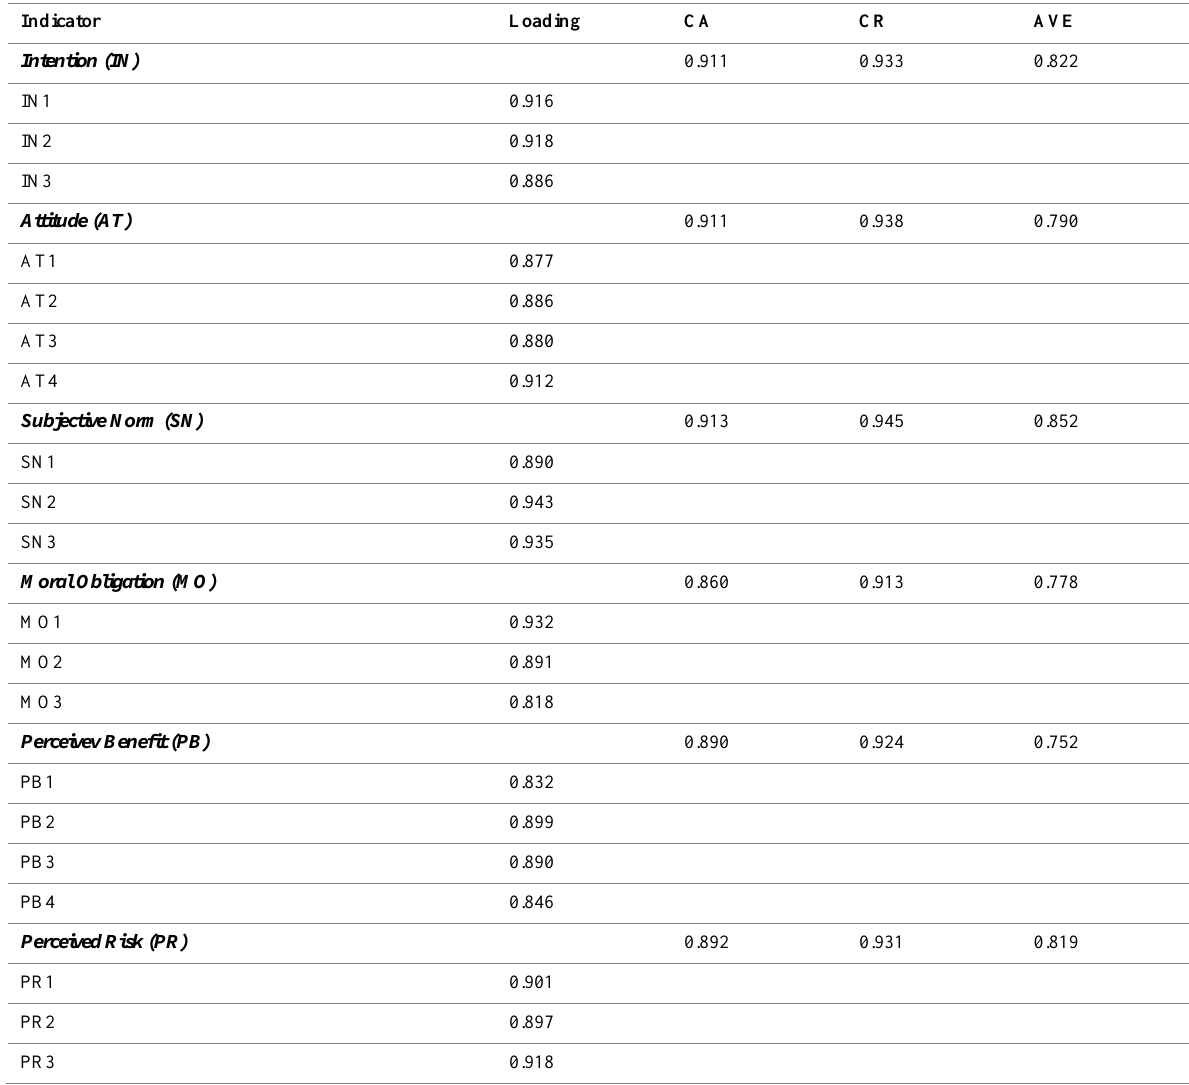
Table 1: Result of measurement model -reliability Dan Convergent